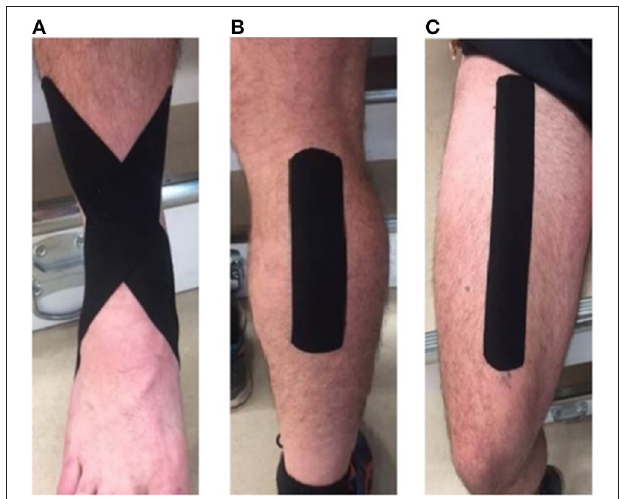
FIGURE 1 | Taping procedures at (A) the ankle, (B) the calf, and (C) the quadriceps.